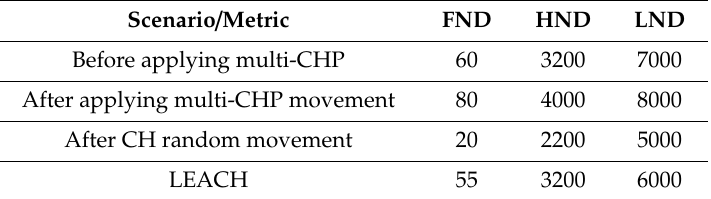
Figure 18. The number of dead nodes after each iteration. Table 3. The FND, HND, and LND metrics for the di ff erent scenarios of Figure